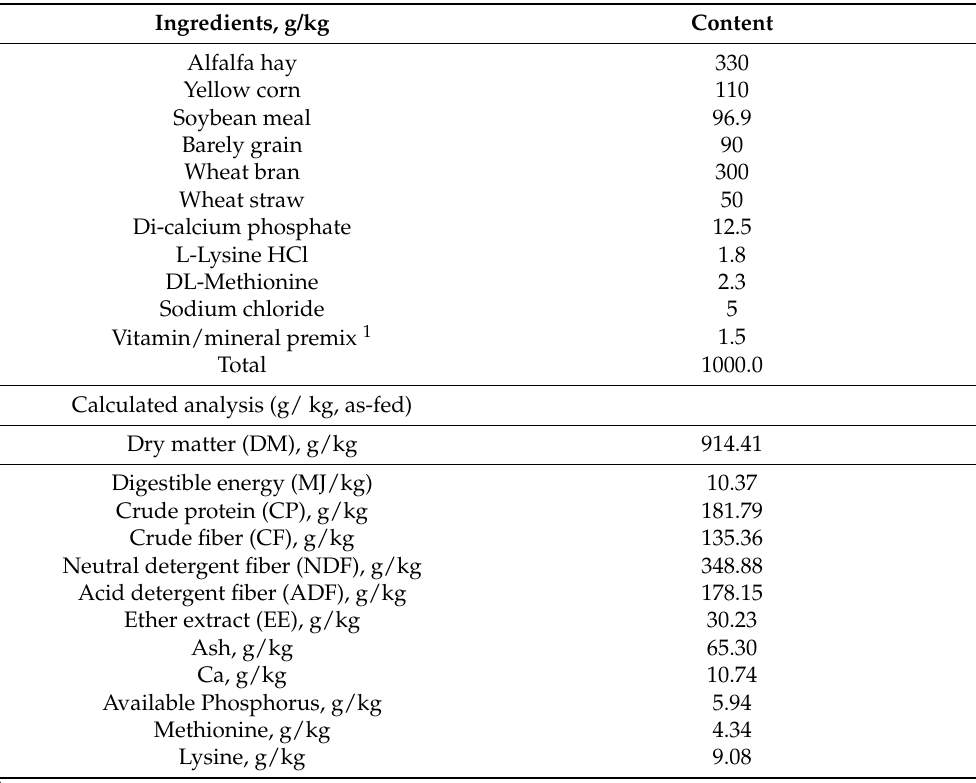
Table 3. Composition and calculated analyses of basal diet (g/kg, as-fed